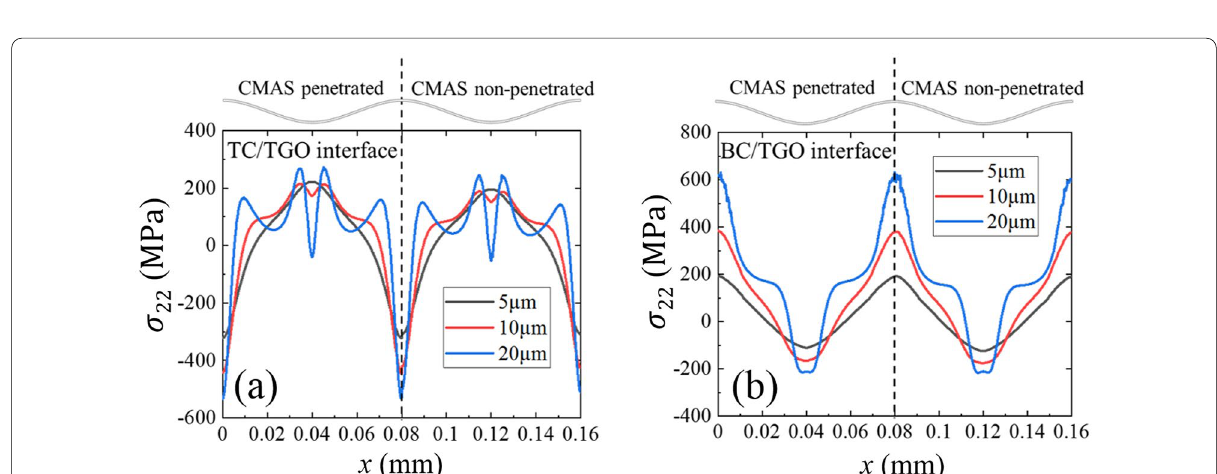
Figure 16 Distribution of σ 22 at TC/TGO and BC/TGO interfaces of Zone II under different interface roughness